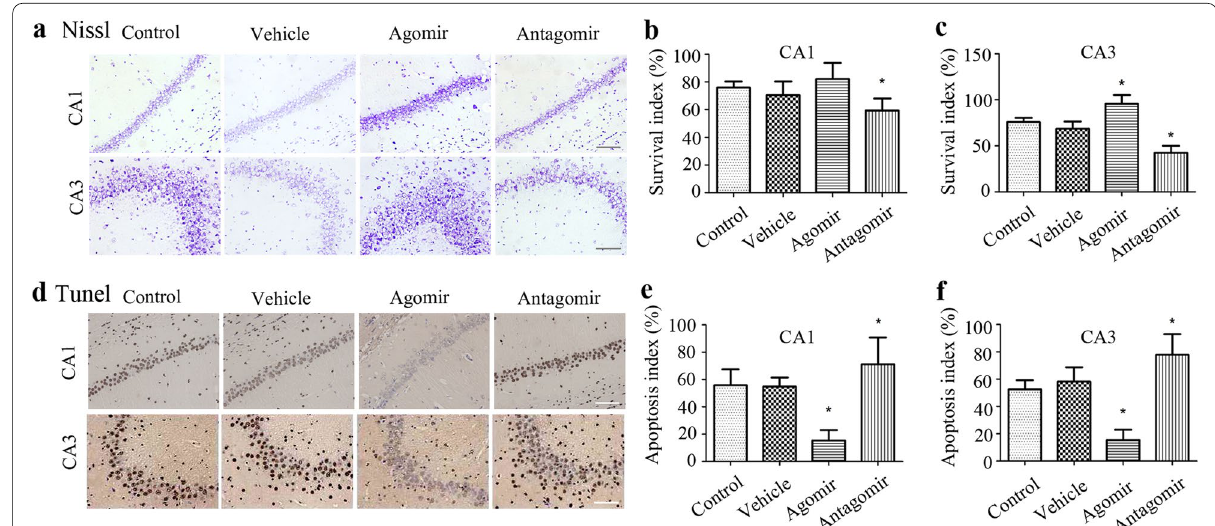
Fig. 4 Effects of the agomir and the antagomir on the survival and apoptosis of neurons in the CA1 and CA3 regions. a Representative images of Nissl staining. Scale bar: 100 μm. b , c Survival index (%) in the CA1 ( b ) and CA3 ( c ) regions of the different groups (* P < 0.05 versus vehicle group; n 3 per group). d Representative images of TUNEL staining in the rat hippocampus. Scale bars: 100 μm. e , f Apoptosis index (%) in the CA1 ( e ) and = CA3 ( f ) regions in the different groups (* P < 0.05 versus vehicle group; n